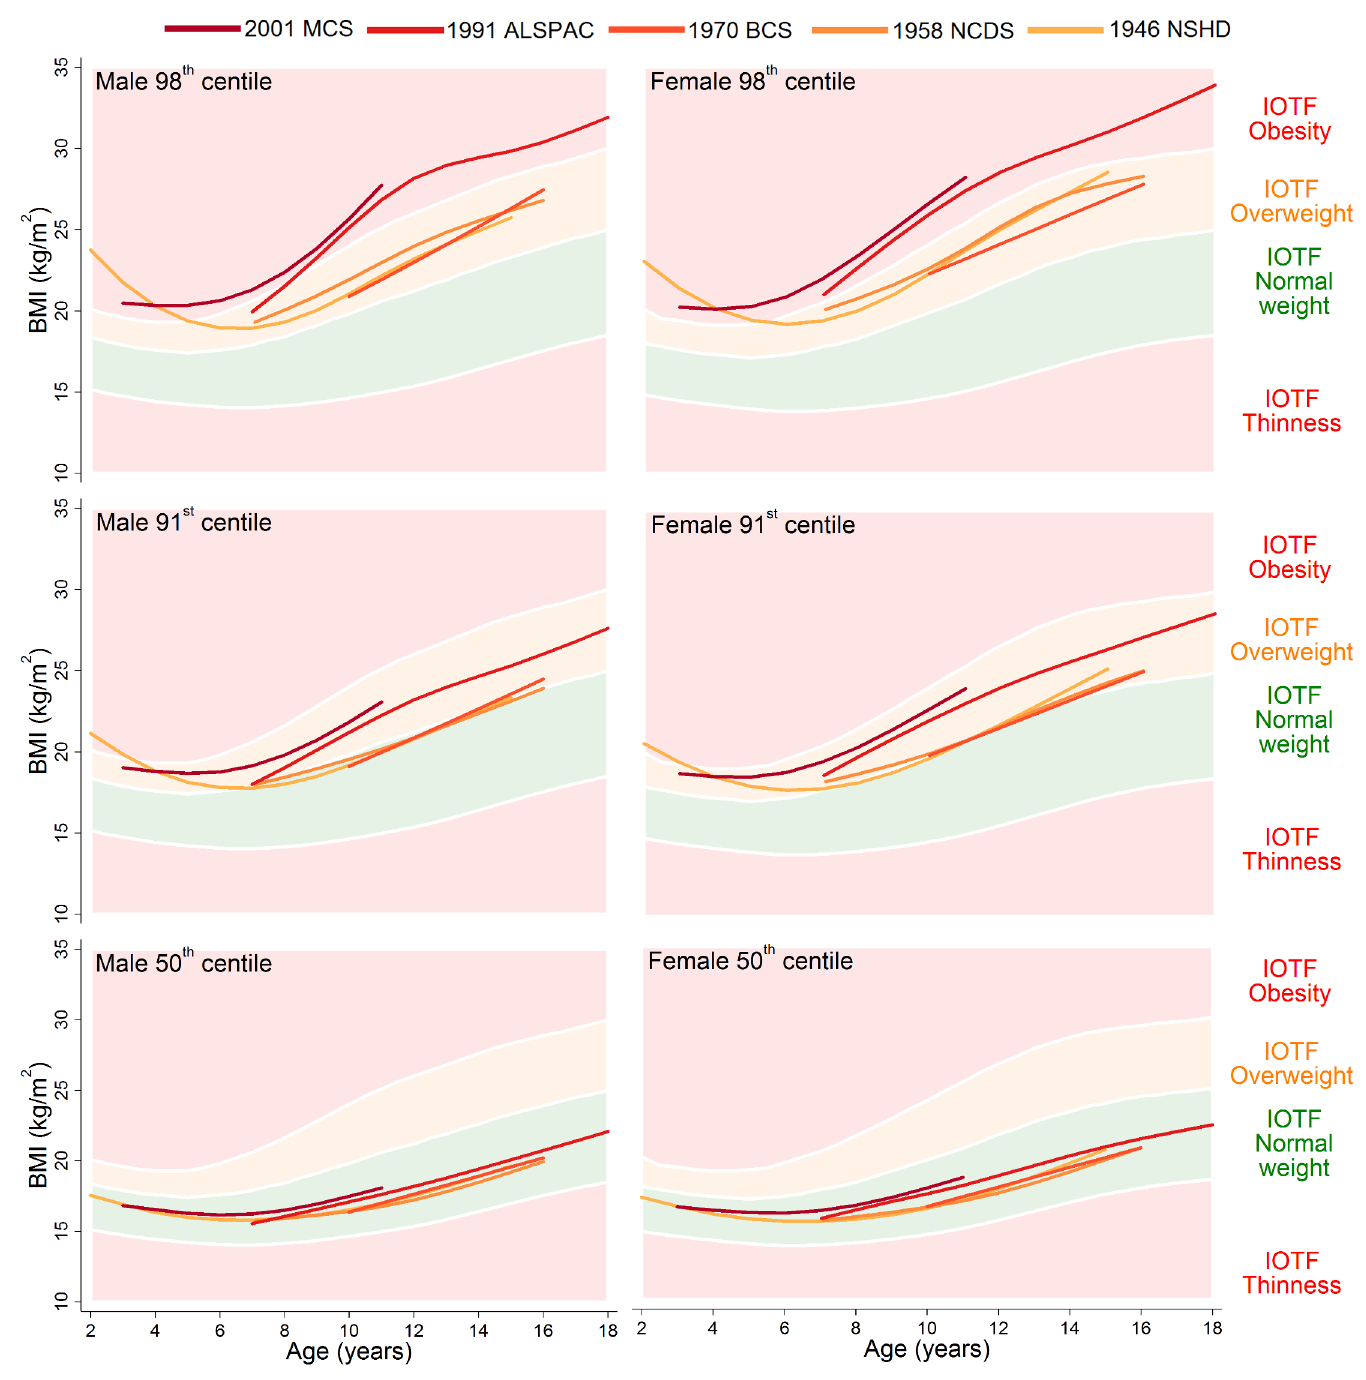
Fig 1. The 98th, 91st, and 50th childhood BMI centiles from sex- and study-stratified LMS models plotted against the IOTF cut-offs. BMI: Body Mass Index, IOTF: International Obesity Task Force, LMS: Lambda-Mu-Sigma, NSHD: Medical Research Council National Survey of Health and Development, NCDS National Child Development Study, BCS: British Cohort Study, ALSPAC: Avon Longitudinal Study of Parents and Children, MCS: Millennium Cohort Study.